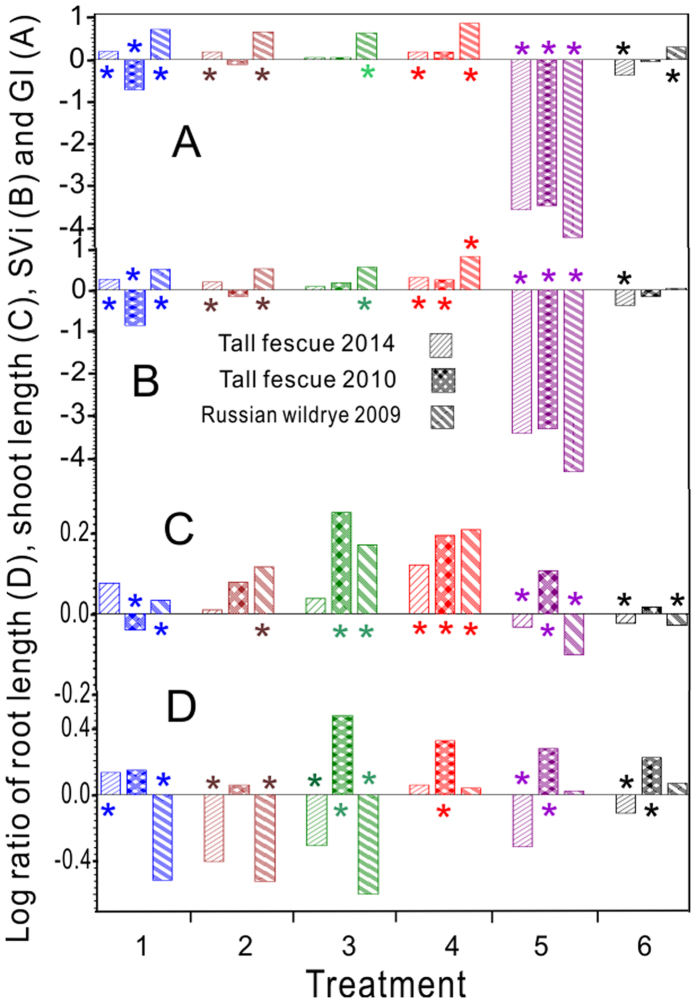
Log ratios of germination index (GI, A), seed vigour index (SVi, B), and lengths of shoots (C) and roots (D). * Indicates the difference between the treatment and the control was significant at p < 0.05.